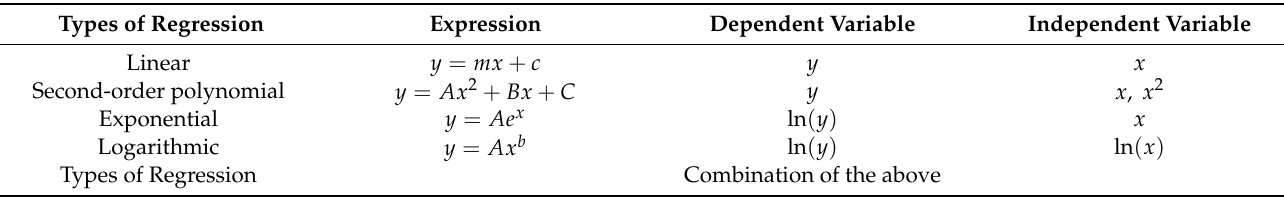
Table 1. Regression expression for different relationships.